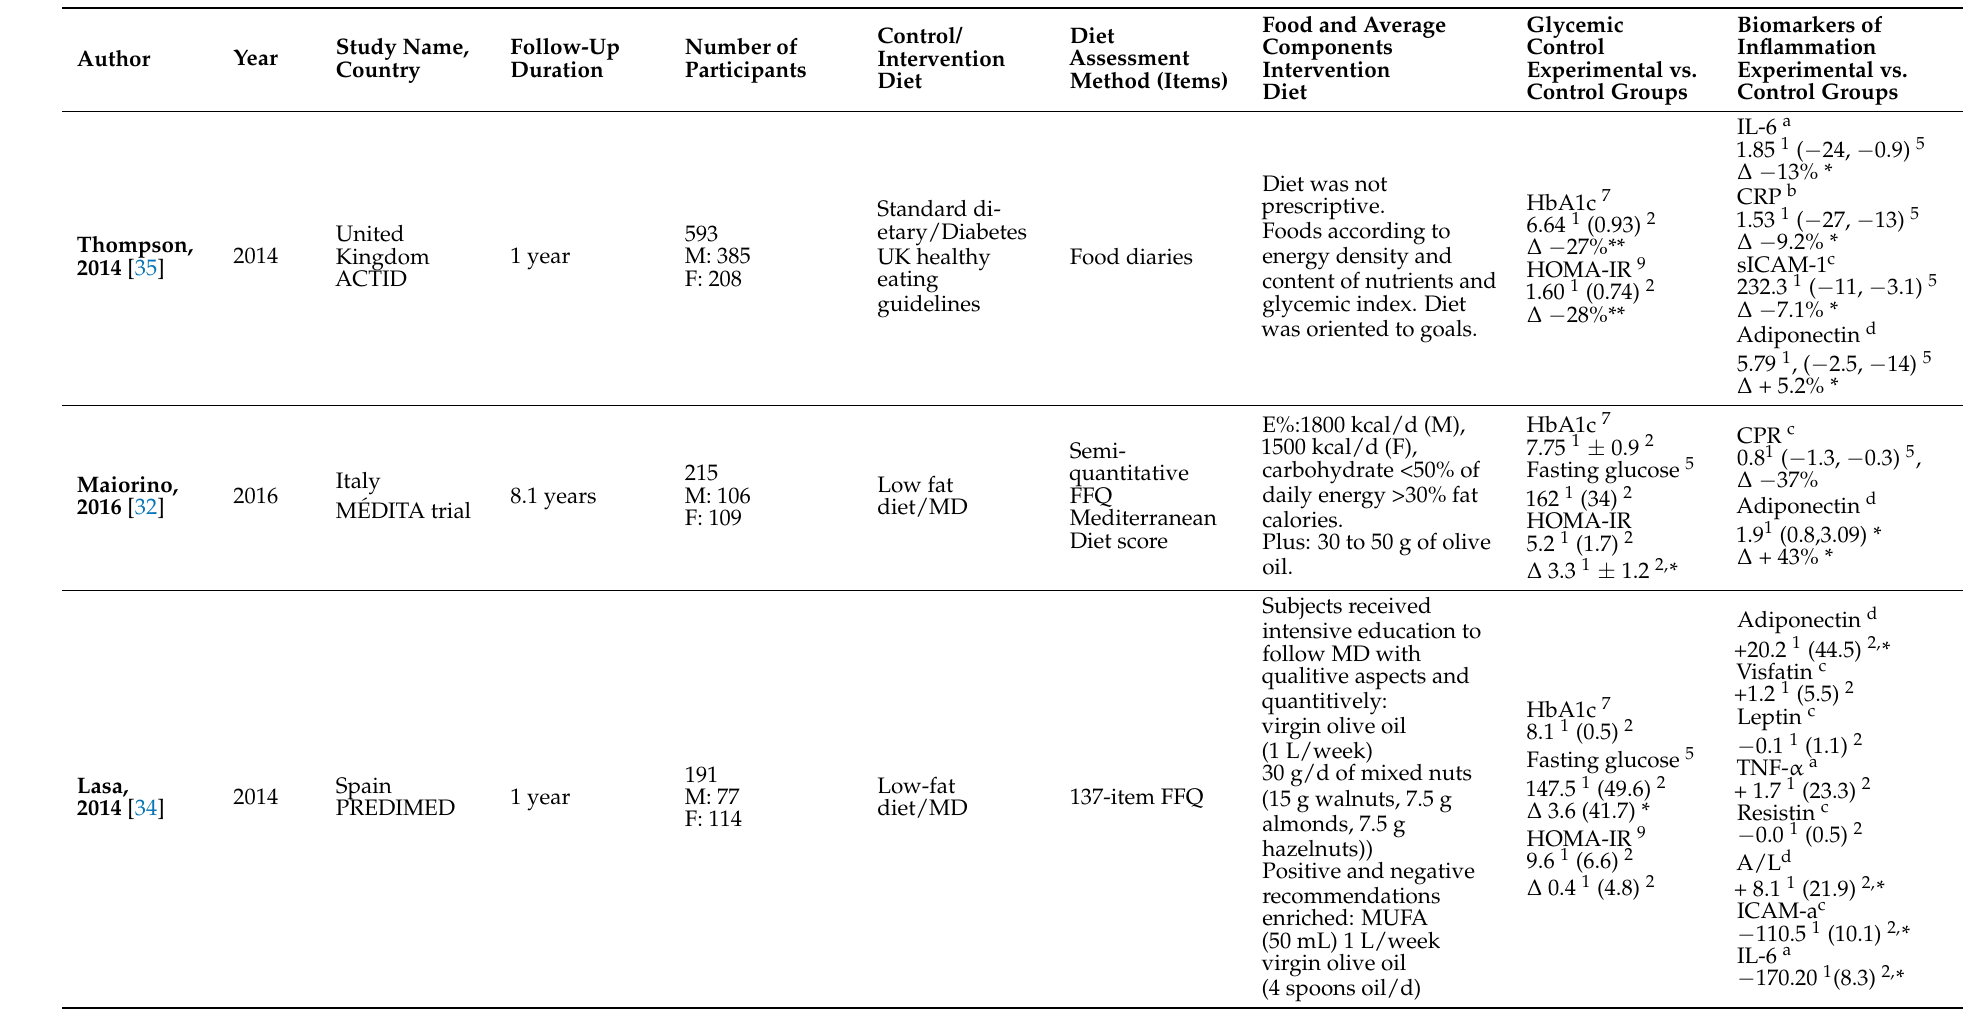
Table 1. Summary table of studies included.